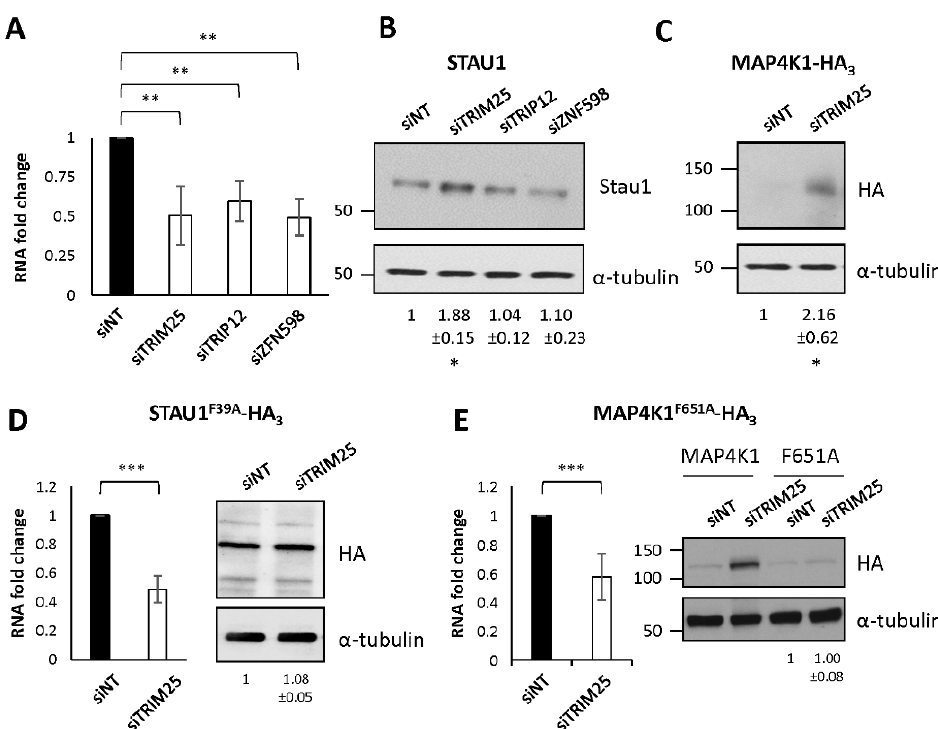
Figure 6. TRIM25 is involved in STAU1 55 and MAP4K1 degradation via the FPL-motif. ( A ) HEK293T cells were transfected with siRNA against the E3 ubiquitin ligases TRIM25, TRIP12, or ZNF598. After 24 h, RNAs were purified from cell extracts and the amounts of mRNA coding for the E3 ligases quantified by RT-qPCR. Their amounts were normalized over that of HPRT and RPL22. The ratio in cells transfected with nontargeting siRNAs (siNT) was arbitrarily fixed to 1. **, p value ≤ 0.01 (Student t -test). ( B ) siRNA-transfected cells were lysed, and the amounts of endogenous STAU1 55 proteins analyzed by Western blot using anti-STAU1 and anti-tubulin antibodies. ( C ) HEK293T cells were cotransfected with plasmid coding for MAP4K1-HA 3 and siRNA against TRIM25. Protein extracts were analyzed by Western blotting using anti-HA and anti-tubulin antibodies. The ratio of the amounts of the expressed proteins on that of tubulin in control cells was arbitrary fixed to 1. The numbers represent the means ± standard deviation of the relative amounts of the proteins in three independently performed experiments. *, p value ≤ 0.05 (Student t -test). ( D , E ) HEK293T cells were transfected with siRNA against the E3 ubiquitin ligase TRIM25 and plasmids coding for STAU1 F39A -HA 3 ( D ) or MAP4K1 F651A -HA 3 ( E ). MAP4K1-HA 3 was used as control. After 24 h, RNAs were purified from cell extracts and TRIM25 mRNA quantified by RT-qPCR (left panels). The amount was normalized as in ( A ). Protein levels were analyzed by Western blot (right panels) using anti-HA and anti-tubulin antibodies. The blots are representative of three independently performed experiments that gave similar results. The numbers below the gels represent the means ± standard deviation of the relative amounts of the proteins in three independently performed experiments. The ratio of the amount of the proteins to that of tubulin in siNT-transfected cells was arbitrary fixed to 1. ***, p value ≤ 0.001 (Student t